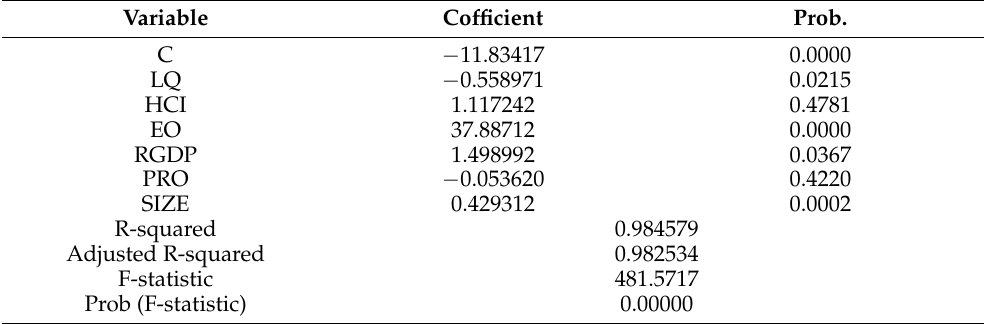
Table 9. Regression results of the effect of industrial agglomeration on eco-innovation performance.